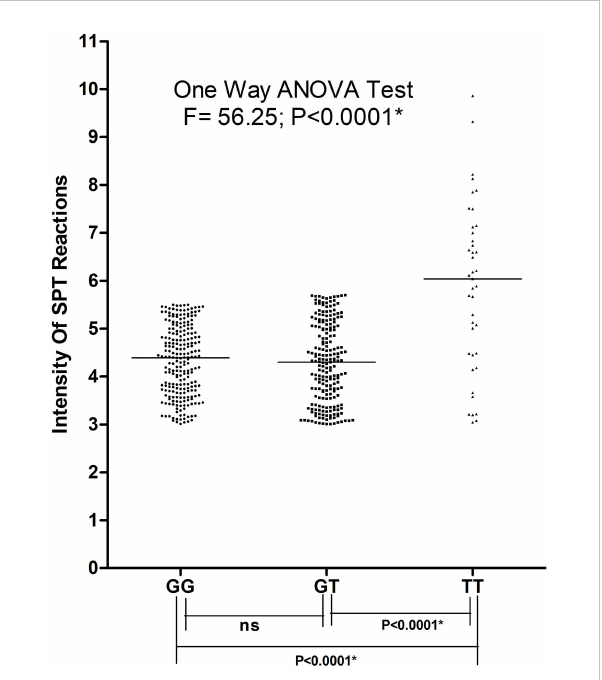
diameter) in all age groups and in both sexes which clearly indicated a role of atopy in lung function impairment. Various studies were conducted previously showing association of allergen sensitization and asthma severity in terms of spirometric parameters (43, 44). Jaen et al. 2002 (45) reported that asthmatics sensitized to various allergens including pollens have signi fi cantly lower FEV1/FVC ratio which is in accordance with our result. Allergens are thought to initiate acute episodes of asthma through in fl ammatory processes and bronchial hyper-responsiveness that might result into airway